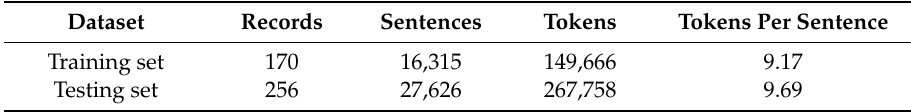
Table 1. Descriptions of training set and testing set in the 2010 Informatics for Integrating Biology & the Bedside / Veterans A ff airs (i2b2 / VA) dataset.